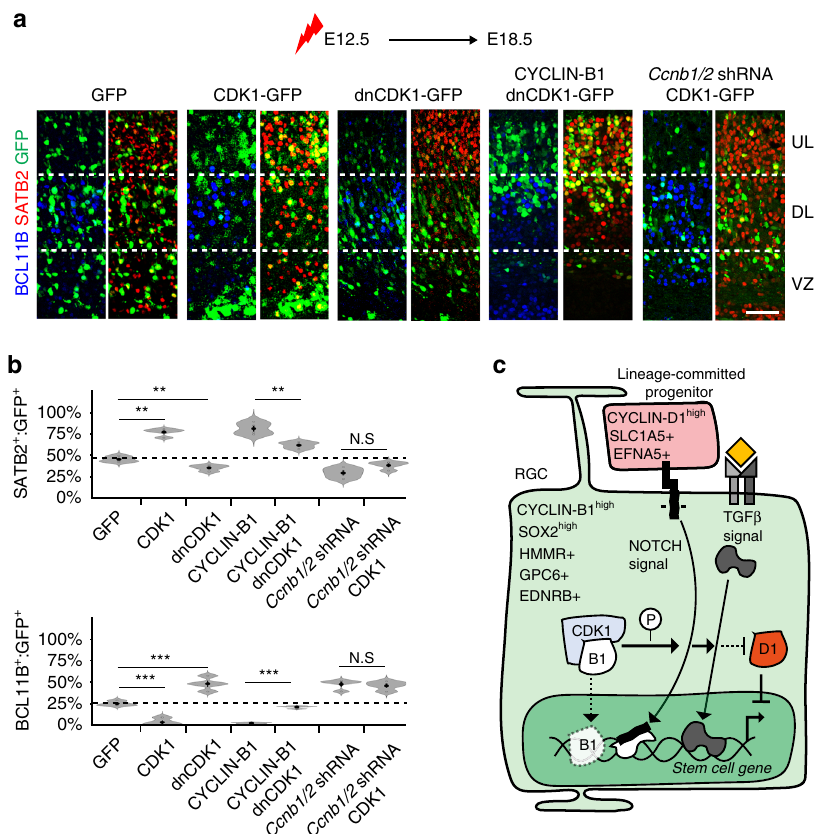
Fig. 9 CDK1 acts together with CYCLIN-B1/2 in regulating corticogenesis. a , b Immunohistochemistry ( a ) and quanti fi cation ( b ) of GFP + cells (green) expressing BCL11B (blue) or SATB2 (red) in E18.5 cortices after misexpressing GFP alone or together with CDK1, dnCDK1, CYCLIN-B1, CYCLIN-B1 and dnCDK1, Ccnb1/2 shRNA or Ccnb1/2 shRNA and CDK1 at E12.5 ( n = 4 biological independent experiments). P -values BCL11B expression (vs. GFP); CDK1 3.17e-4, dnCDK1 4.8e-3 and CYCLIN-B1/dnCDK1 6.78e-6. P -values SATB2 expression (vs. GFP); CDK1 5.7e-5, dnCDK1 5.17e-3 and CYCLIN-B1/dnCDK1 5.6e-3. Violin plots are inset by rings corresponding to the individual data points, a fi lled dot at the group mean and a vertical line showing standard error. Stars indicate signi fi cant differences between indicated groups based on two-tailed t tests, with ** P < 0.01 and *** P < 0.001. c Model summarising features of RGCs and lineage-committed progenitors identi fi ed in this work. According to the model, the kinase activity of CDK1/CYCLIN-B1, and possibly gene regulatory functions on the chromatin level, activate stem cell-regulatory pathways, including those of NOTCH and TGFß, which delay the commitment of RGCs to cortical lineage differentiation. Scale bar represents 40 µ m in ( a ). Source data are provided as a Source Data fi